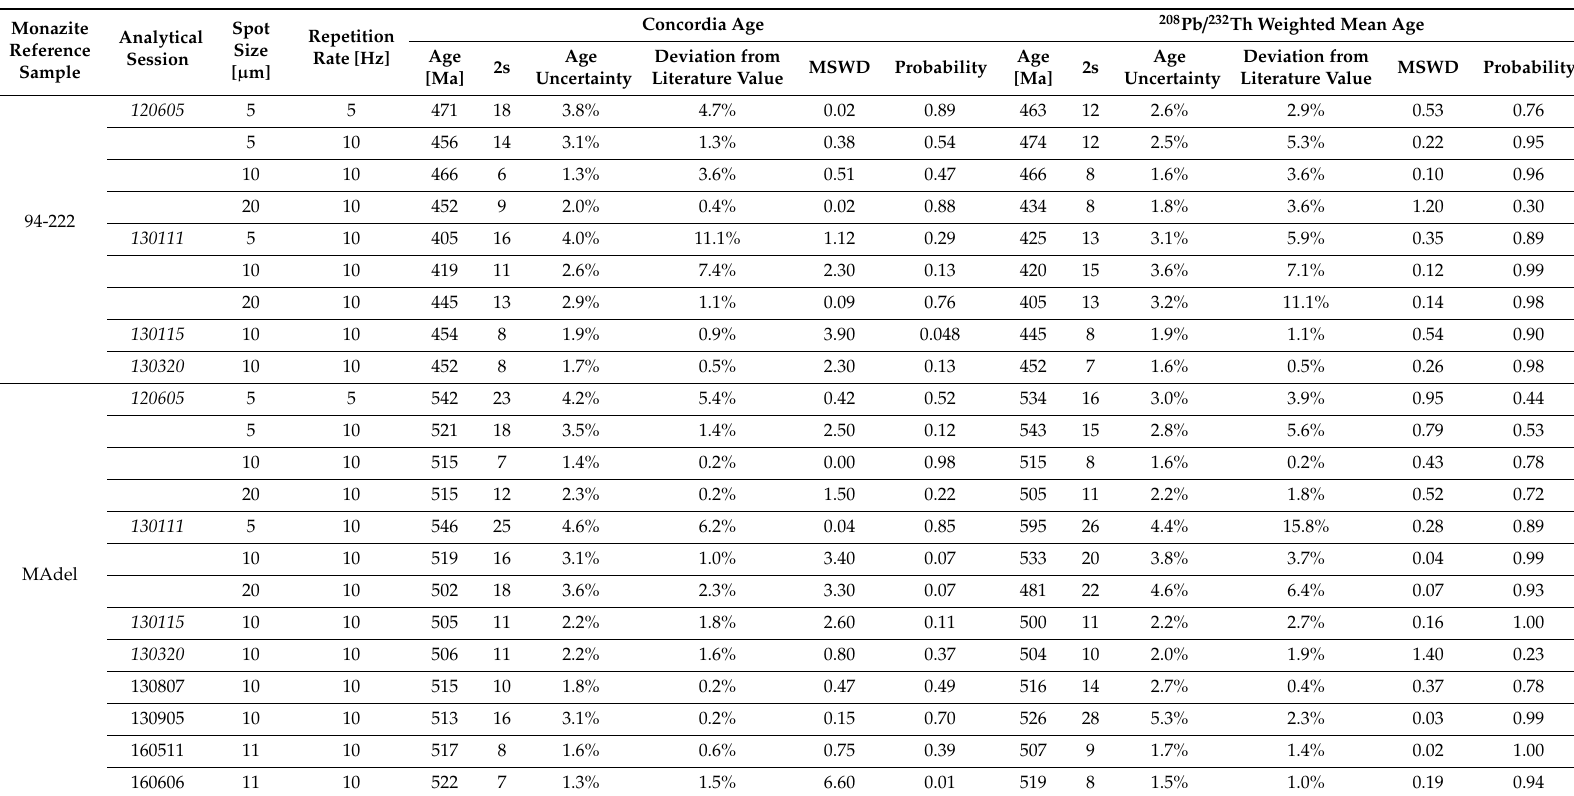
Table 3. Concordia and 208 Pb / 232 Th weighted mean age of 94-222, USGS 40069, MAdel, Moacir and TMM monazite reference samples of each analytical session. The ages presented in this table have been evaluated and reduced using the in-house Excel spreadsheet. Concordia and 208 Pb / 232 Th weighted mean age obtained using the Iolite software is presented in Table S2 and Table S3. Monazite sample USGS 44069 has been used as calibration RM. The uncertainty is given in 2s. The number of spots analyzed is given ‘n’. Data of each spot are provided in Table